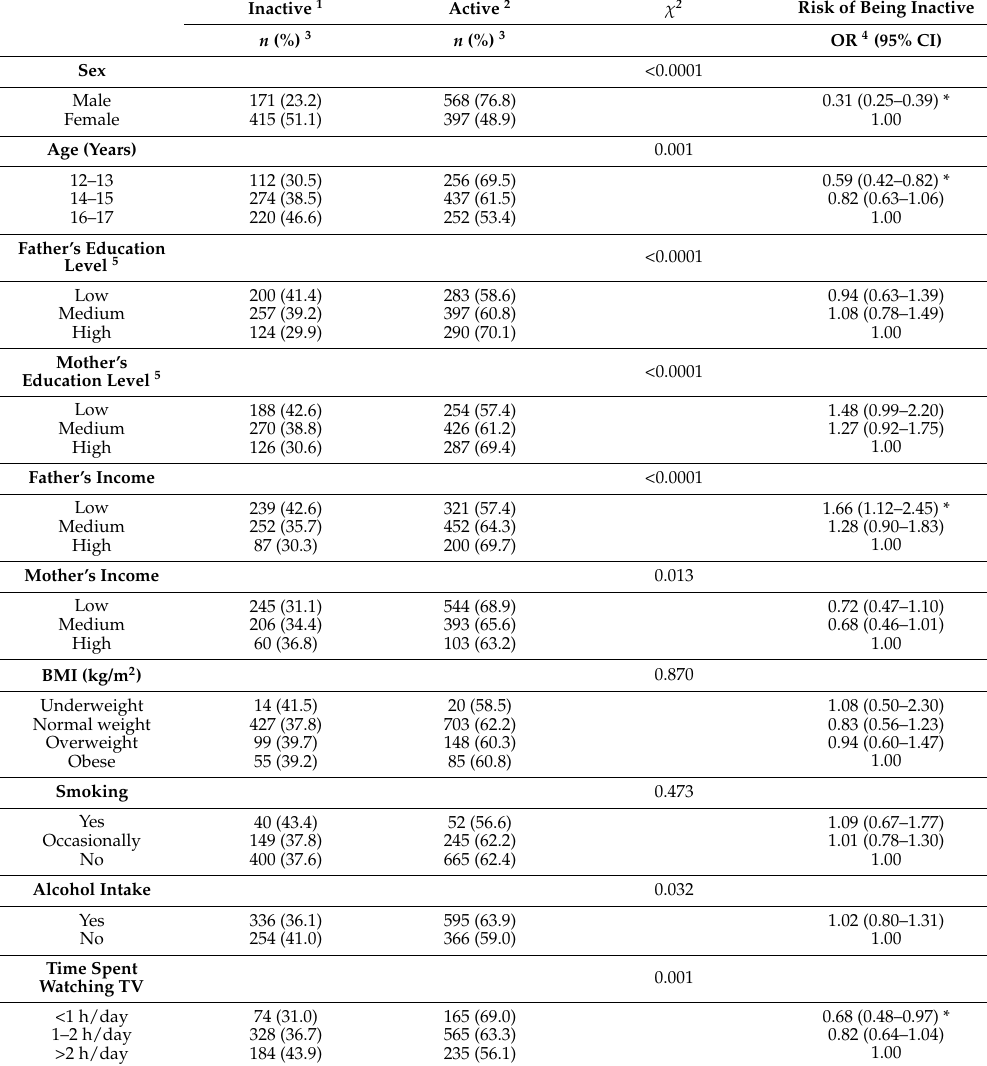
Table 1. Socio-demographic and lifestyle characteristics, according to physical activity and multivariable analysis of risk factors for low physical activity versus moderate and high physical activity